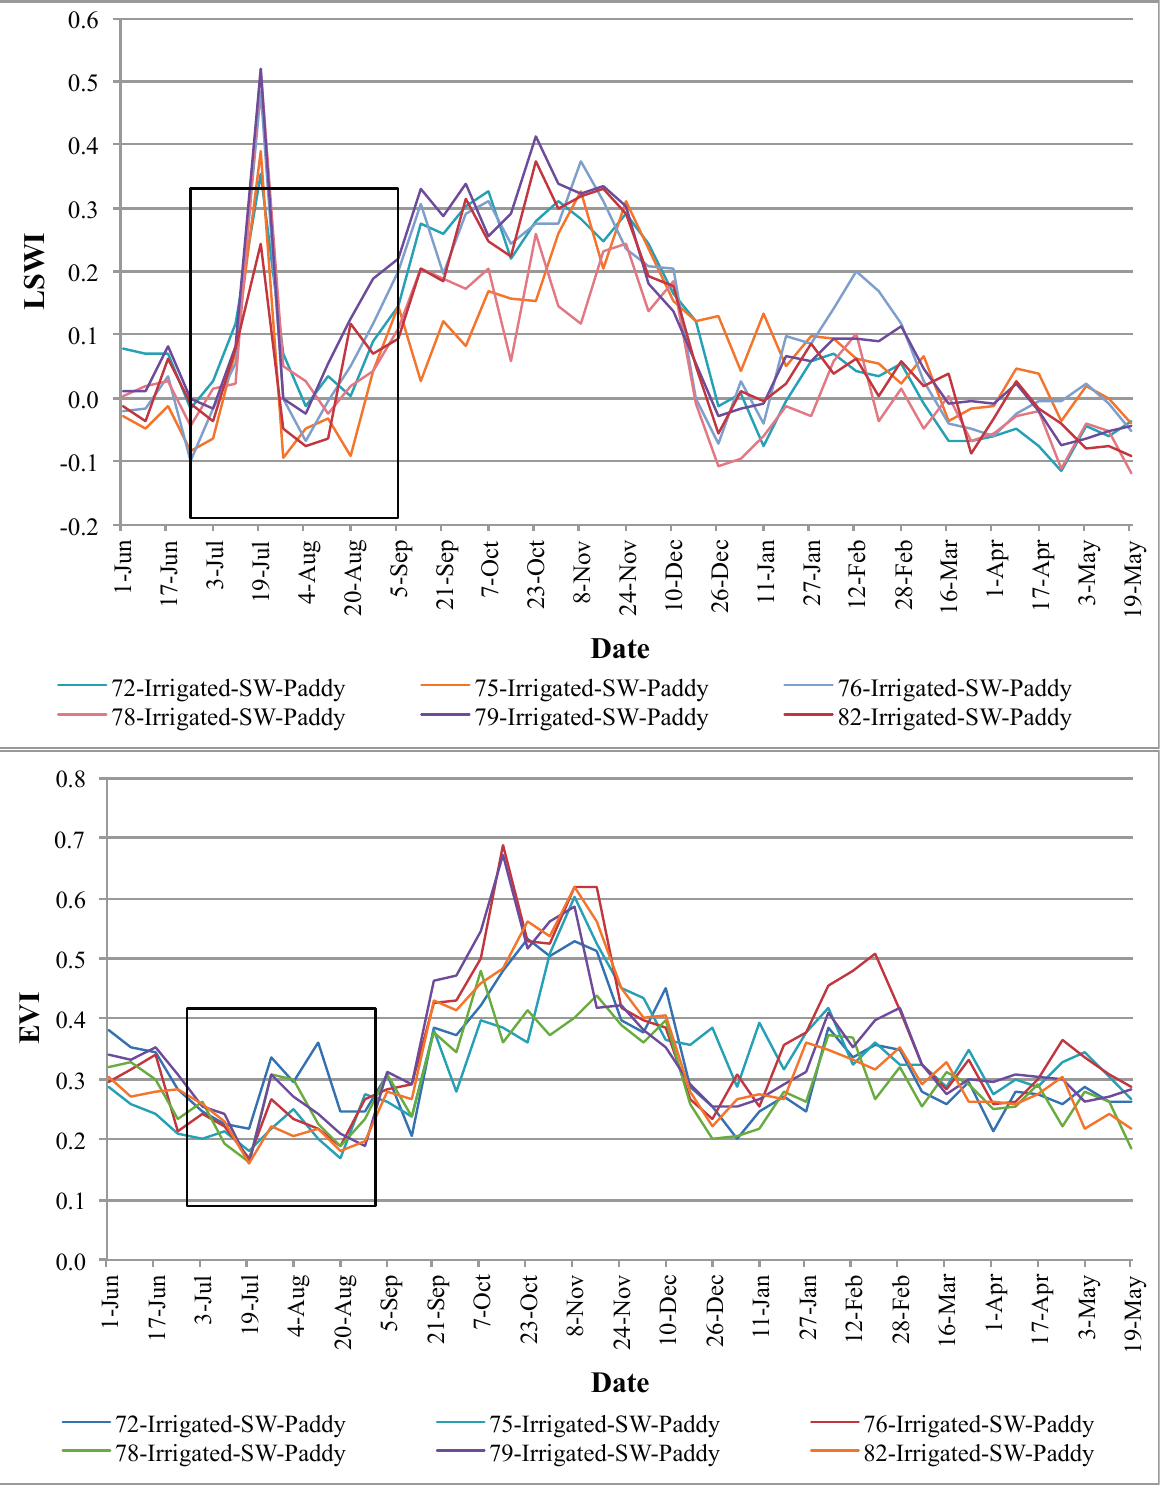
Figure 4. Time series of LSWI and EVI of observed rice fields in the single crop rice zones. The vertical lines represent transplantation season, during this period we can observe inversion of indices for flooded paddy rice